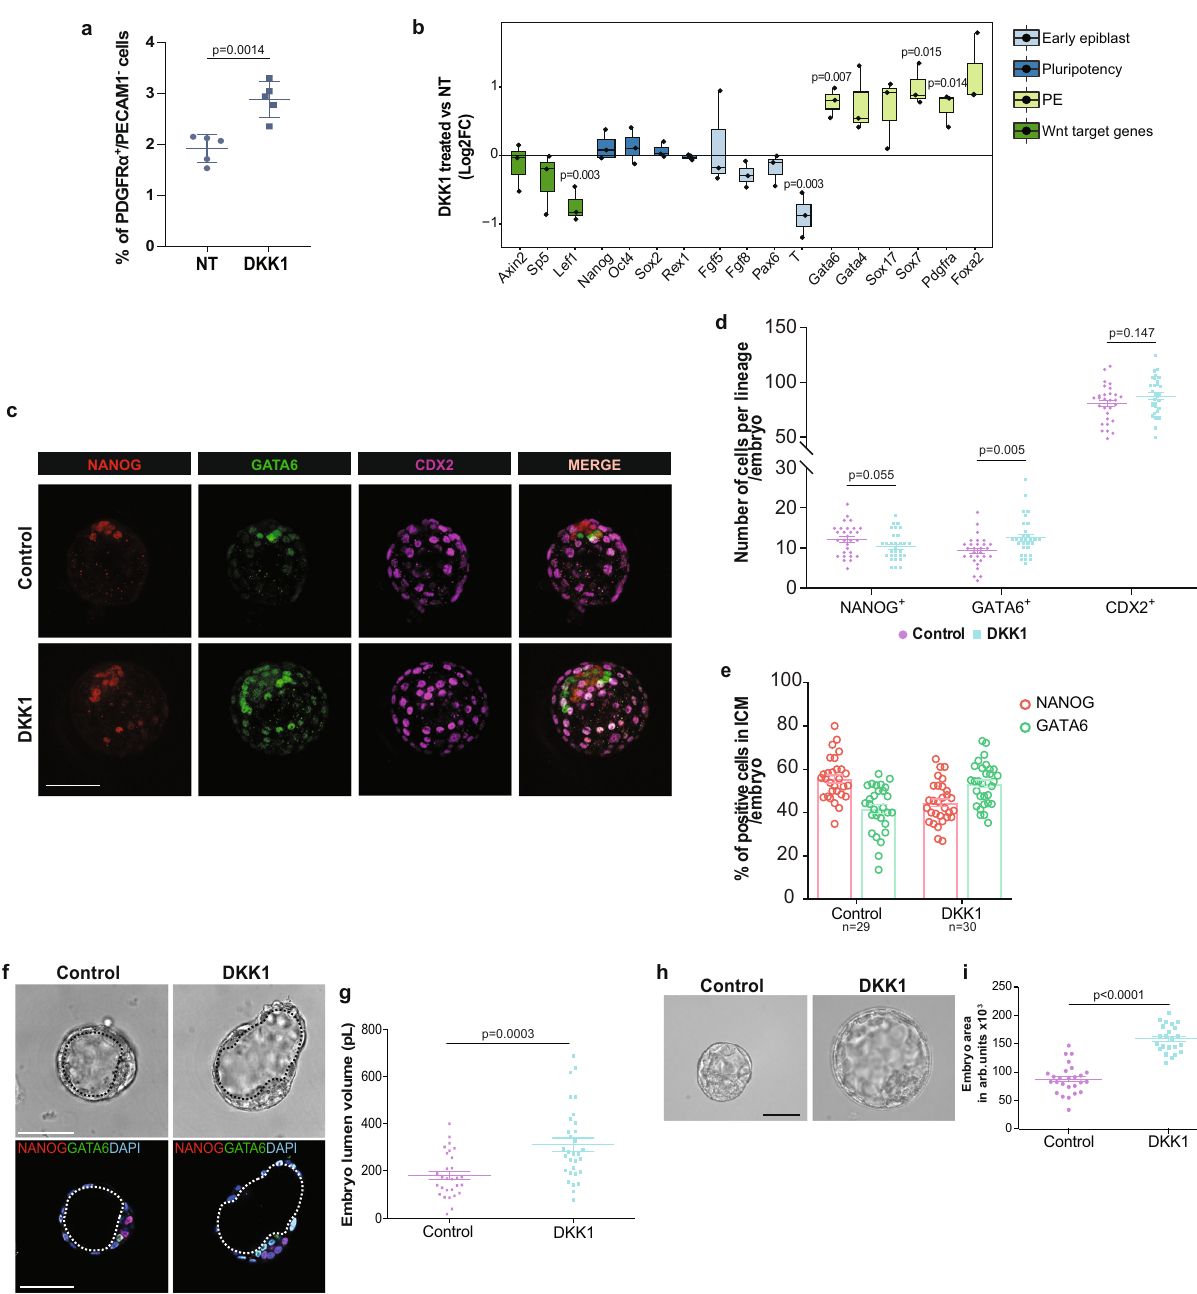
Fig. 2 | Wnt signaling inhibition promotes a shift towards the PE fate. a Percentage of PE-like cells (PDGFR α + /PECAM1 - ) in control and DKK1-treated mESCs. Mean ± SD; n =5 independent experiments, two-tailed unpaired t test. b Gene expression analysis of early EPI, pluripotency, PE and Wnt target genes on control and DKK1-treated mESCs. Horizontal line denotes the median value, box refers to the 25th to 75th percentiles and whiskers mark min and max values. n =3 independent experiments; two-tailed unpaired t test. c Representative IF image of NANOG, GATA6 and CDX2 protein signals in E2.5+48H control and DKK1 treated embryo.Scalebar=50 μ M. d NumberofNANOG + ,GATA6 + andCDX2 + cells(counts) perembryo.Mean±SEM;Control: n =29;DKK1n=30;3independentexperiments;